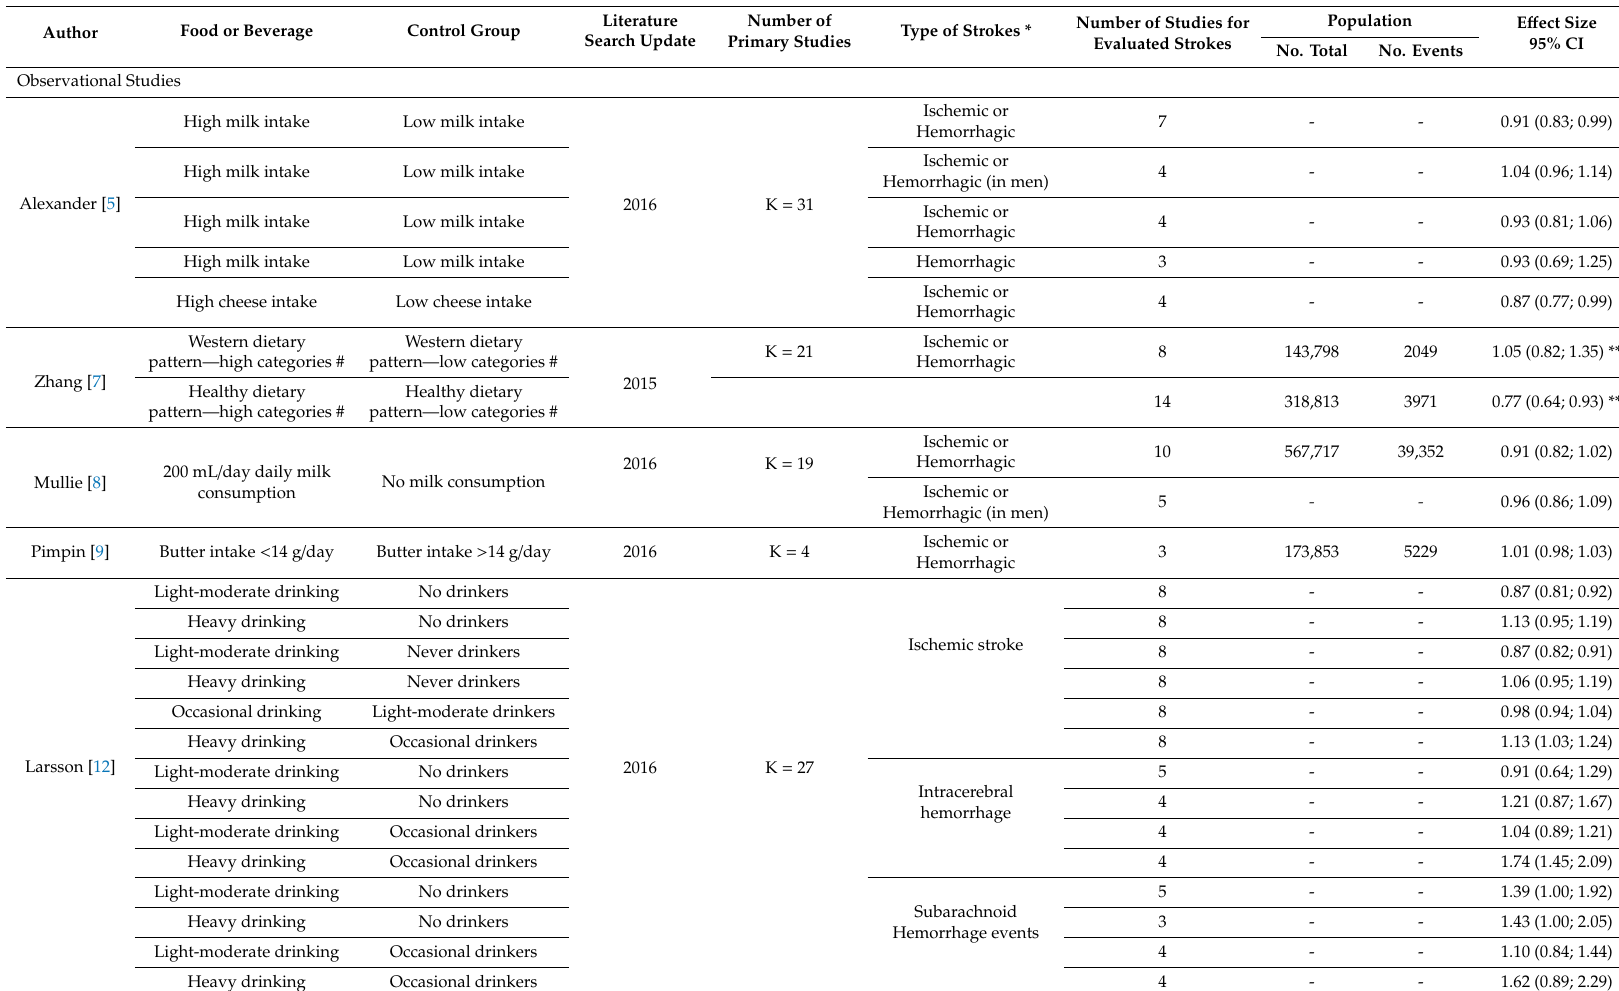
Table 1. Characteristics of included meta-analyses in the overview according to food or beverage, study design, and type of